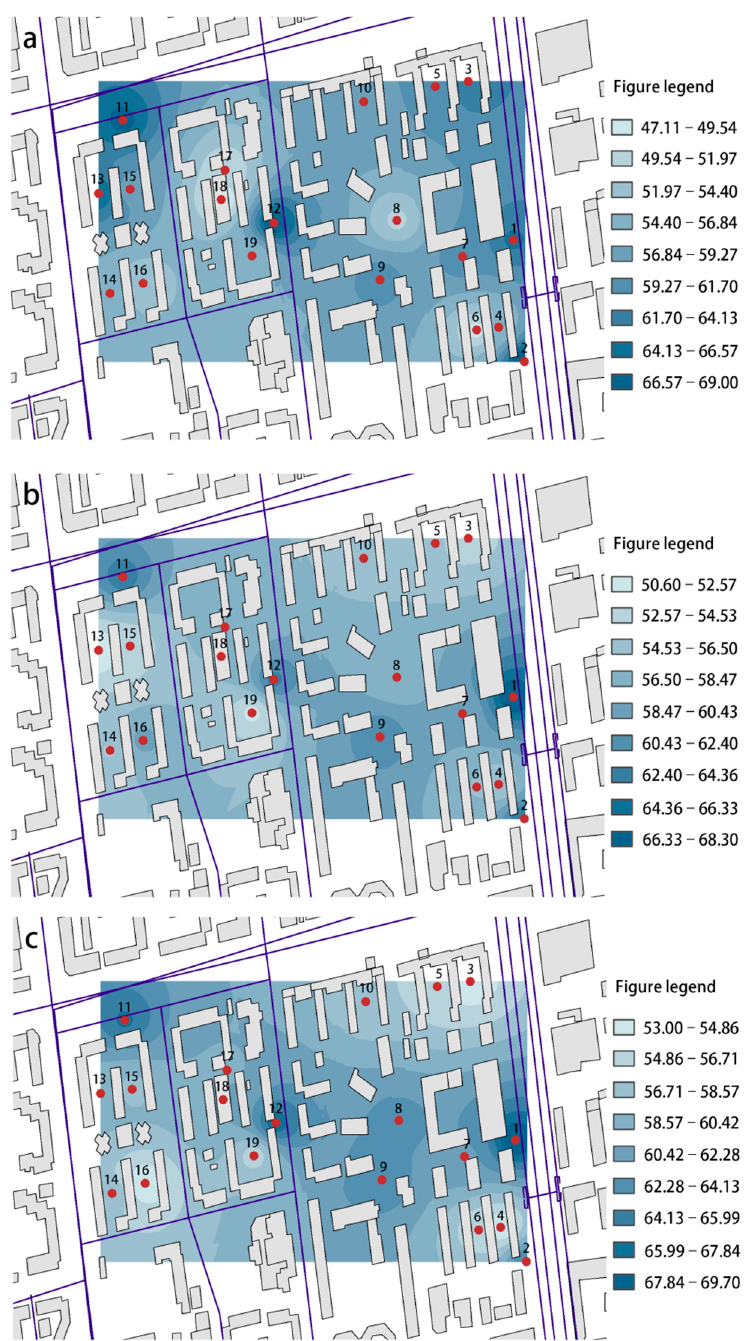
Figure 3. The SPL distribution of the study area during different periods (Unit: dB(A)): ( a ) 8:00–